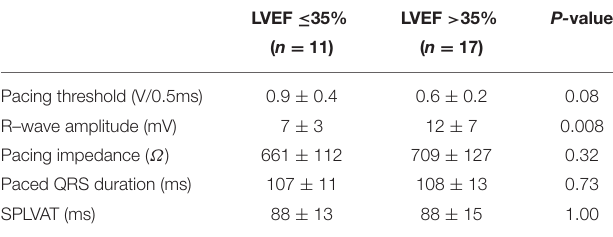
TABLE 2 | Pacing parameters in successful LBBAP